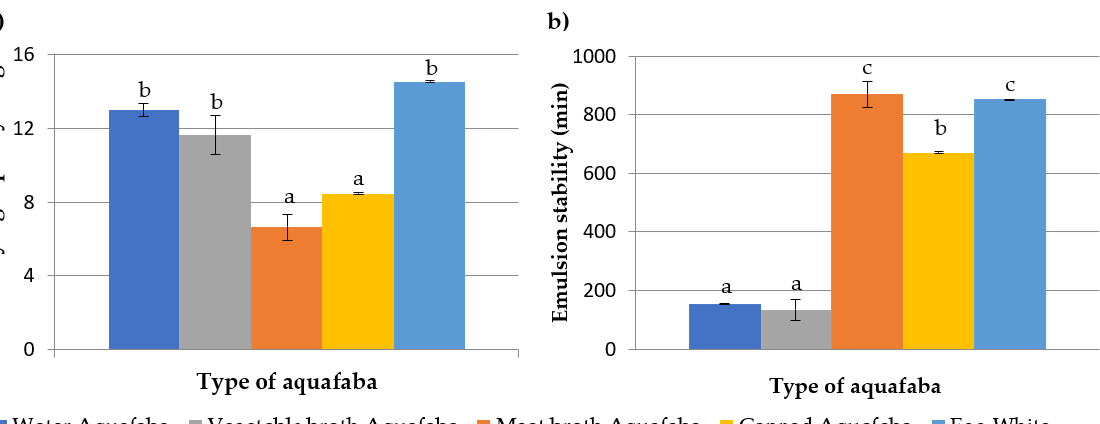
Figure 2. Emulsifying capacity, expressed as m 2 /g ( a ), and emulsion stability, expressed in min ( b ), of Pedrosillano chickpea quafaba obtained with different broths and egg white. a – c Means with different superscripts showed significant differences ( p < 0.05).